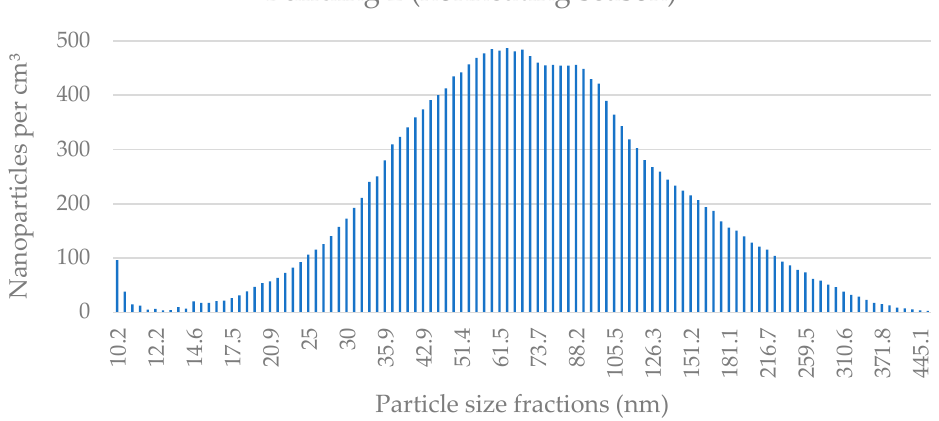
Figure A3. The average nanoparticle concentration in each size fraction in Building 2 during a one-week measurement period during the heating season.